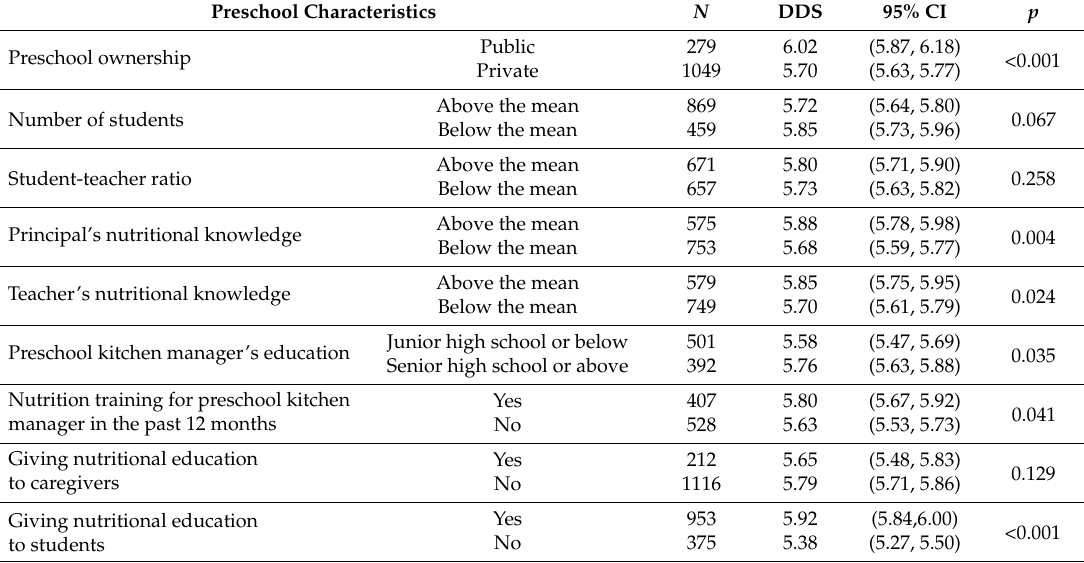
Table 4. The DDS and preschool characteristics.